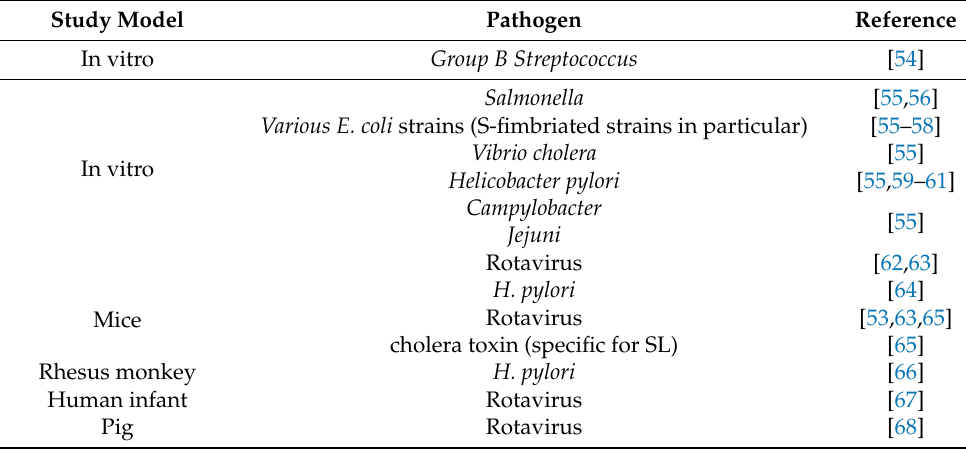
Table 1. Microorganisms against which sialic acid exhibits inhibitory/decoy